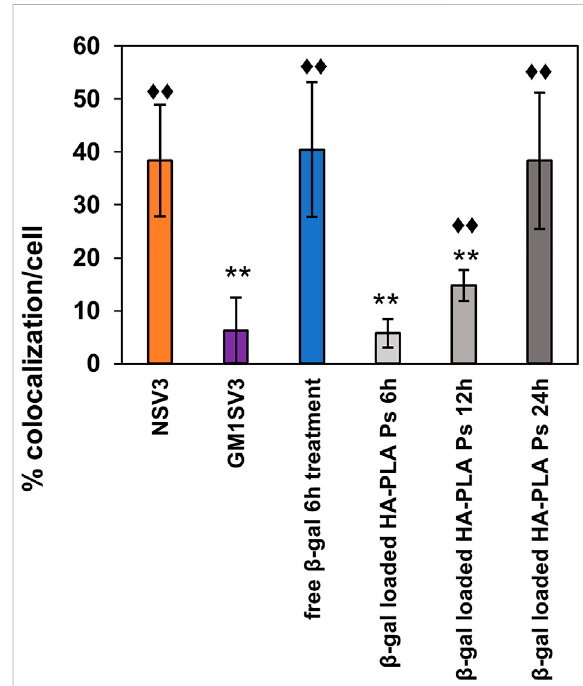
FIGURE 8 Co-localization (%) in untreated healthy (NSV3) and diseased (GM1SV3)cells,GM1SV3cellstreatedwithfree β gal(6 htreatment), β gal-loaded hyaluronic acid-polylactic acid (HA-PLA) polymersomes for 6, 12 and 24 h. These results indicate that HA-PLA polymersomes achieved a therapeutic effect in 24 h, similar to 6 h of treatment with free β gal, due to the slow and controlled release of encapsulated β gal. Star (*) indicate a signi fi cant difference compared to NSV3 cells and diamond ( ◆ ) indicates a signi fi cant difference in colocalization compared